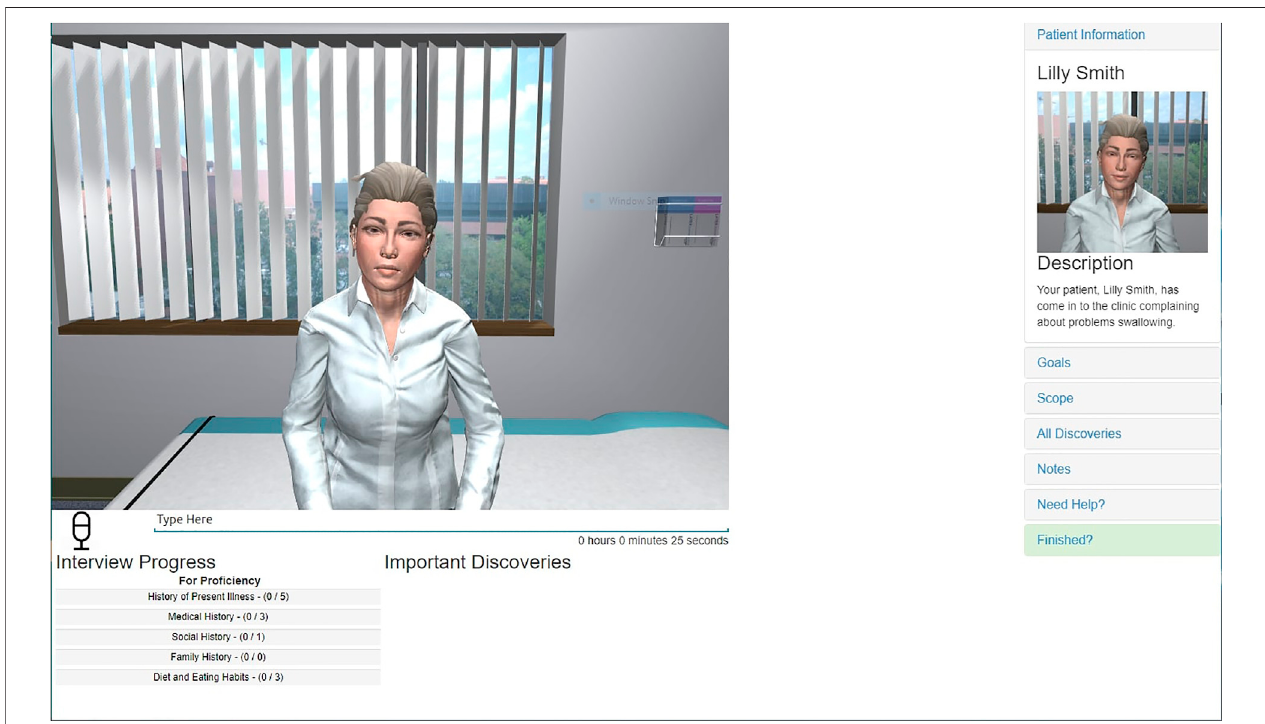
FIGURE 1 | A screenshot of VPF2 ’ s chat interface with Lilly